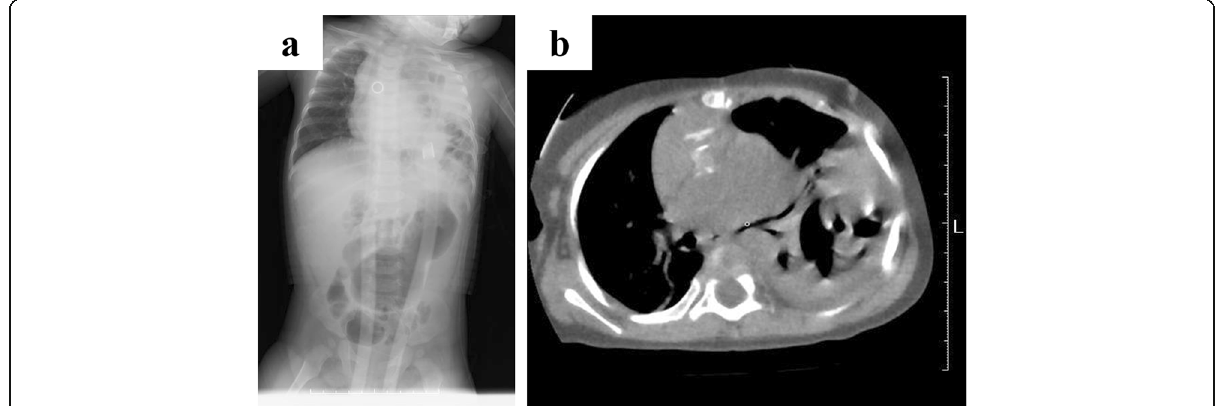
Fig. 1 Preoperative radiological findings. a Plain X-ray shows suspected bowel in the left thorax. b Computed tomography confirmed diaphragmatic